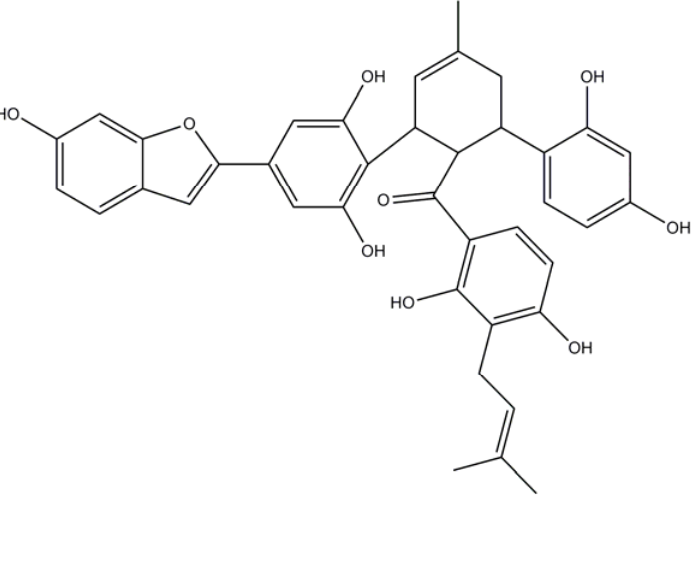
Figure 4. Chemical structure of chalcomoracin identified in induced mulberry leaves (Peak